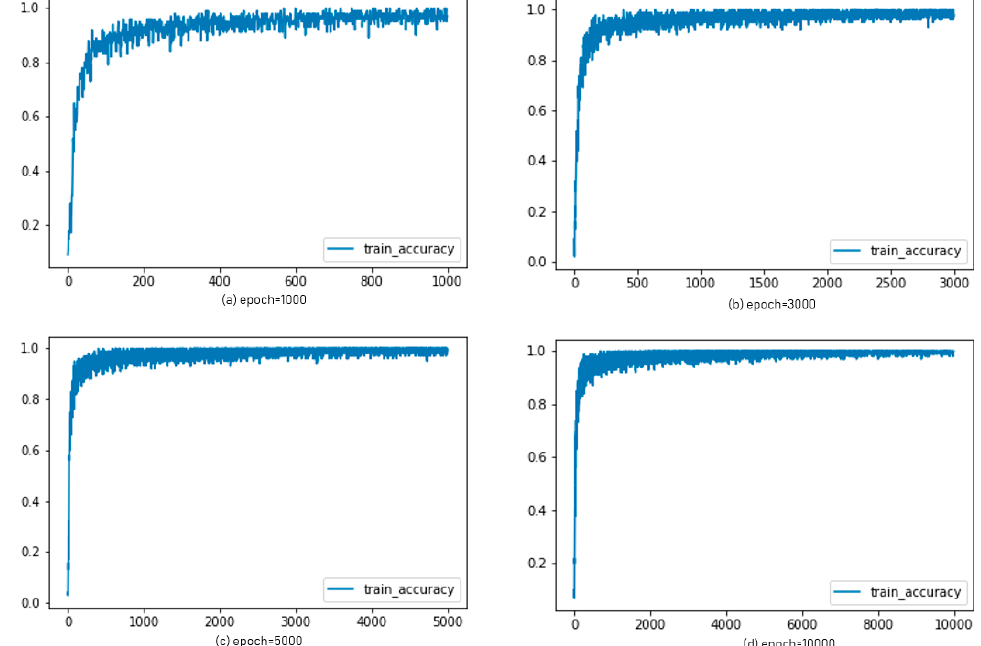
Sensors 2019 , 19 , x FOR PEER REVIEW Figure 13. Experimental results: accuracy of ADAM for each epoch. Figure 13. Experimental results: accuracy of ADAM for each epoch.